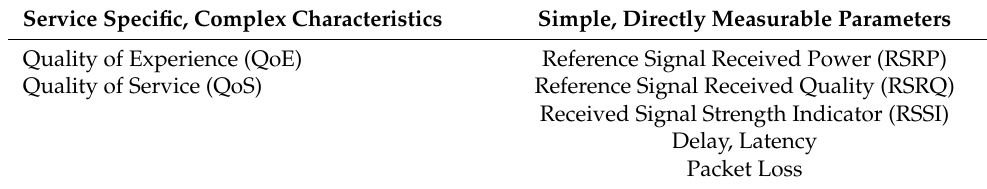
Table 1. Typically assessed parameters , based on